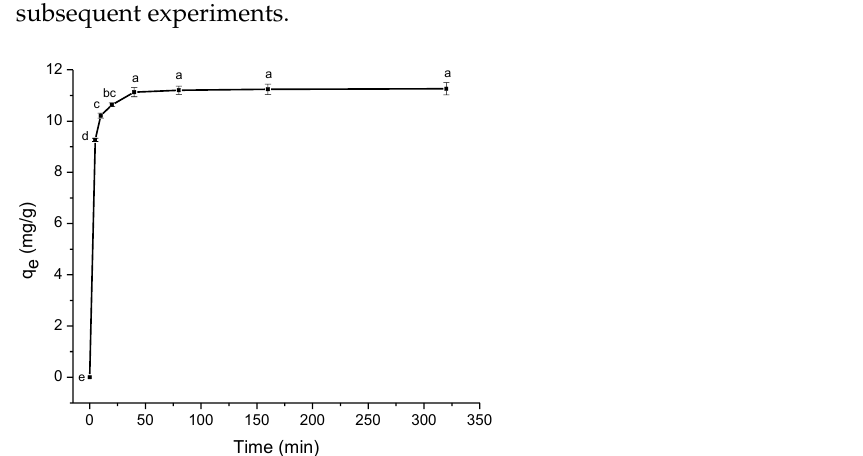
Figure 5. The effect of contact time on the removal of enrofloxacin (adsorbent dose 8 g/L; 100 mg ENR/L; pH 7; and temperature 298 K). Those means that do not share a common superscript differ significantly (Tukey p < 0.05).